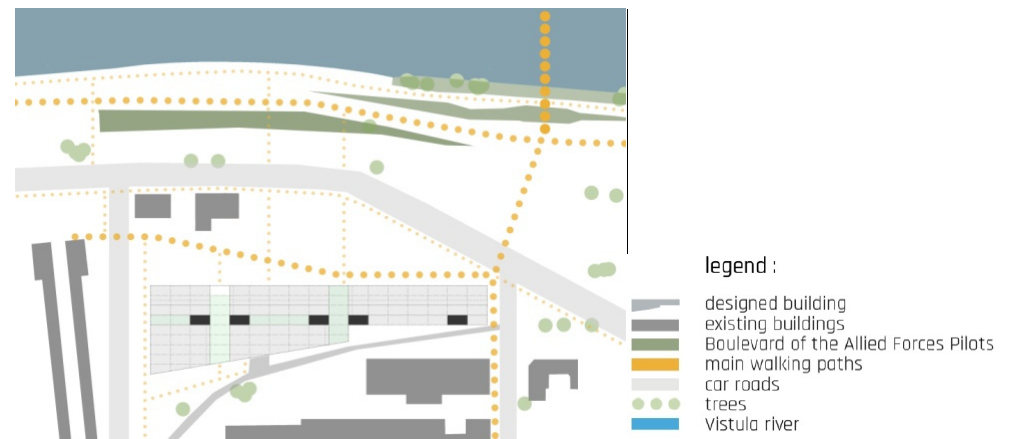
Figure 21. Diagrams showing the location of the study area–transport and circulation, (elaborated by E. Latusek). E. Latusek).